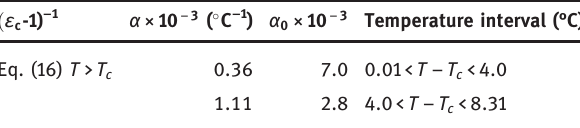
Table 1: Values of the coefficients for the dielectric constant ε c at various temperatures according to eq. (16) in the paraelectric phase ( T > T c ) of TMAHSO 4 using the experimental data [1] within the tem- perature intervals